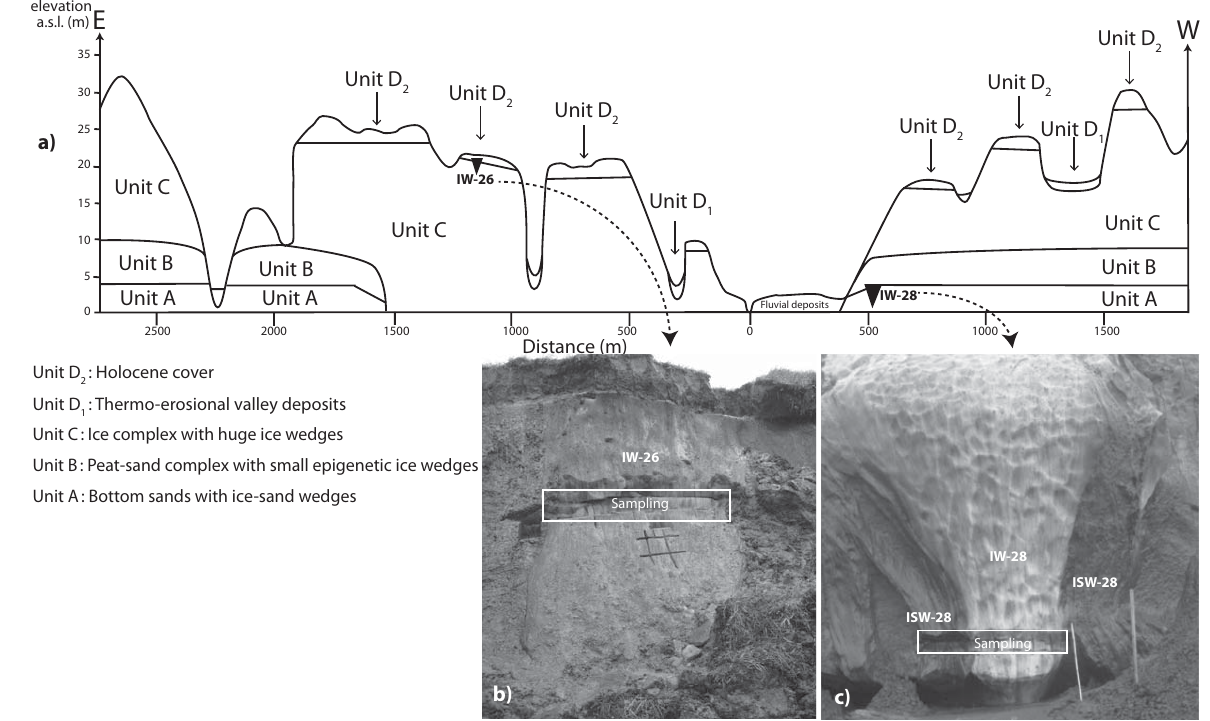
Fig. 2. (a) General stratigraphic scheme of the main section of Mamontov Klyk (adapted from Schirrmeister et al., 2008) with positions and general settings of ice wedges 26 (IW-26) (b) and 28 (IW-28) (c) respectively. The sampling areas are outlined with white boxes, on approximately 160cm and 190cm for respectively IW-26 and IW-28. Rectangular parallelepipeds have been removed from the cliff with chainsaw of which the upper part (1.5cm thickness) has been used in this work. Note that IW-28 was sampled in both the ice-sand wedge (ISW-28, left of box) and in the ice wedge itself (IW-28, right of box).